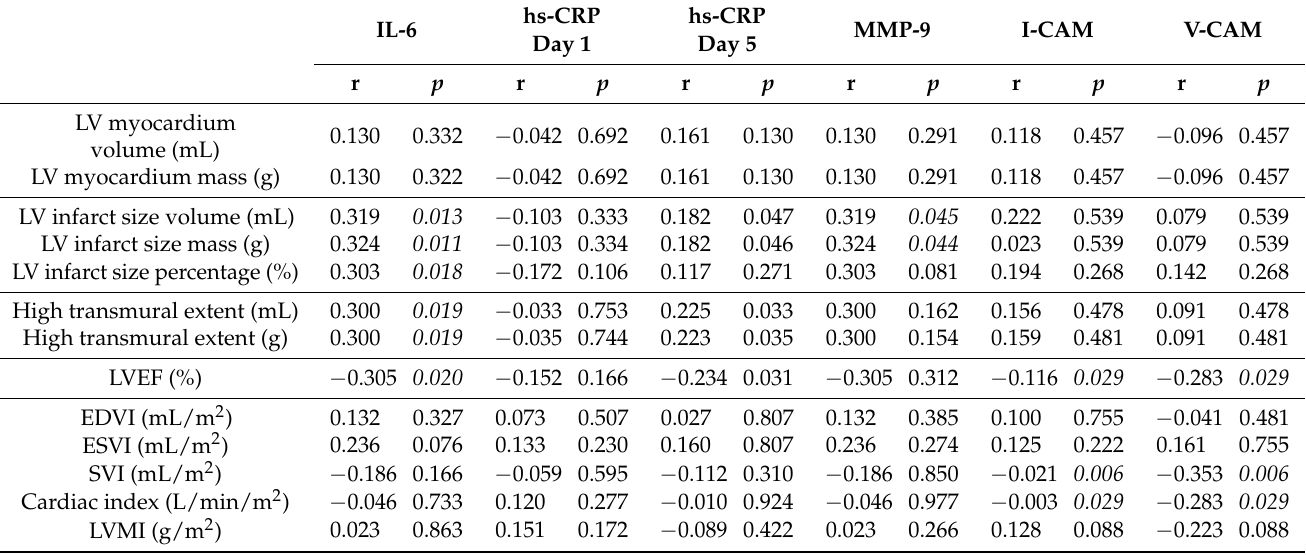
Table 5. Correlations between the inflammatory serum biomarkers and CMR